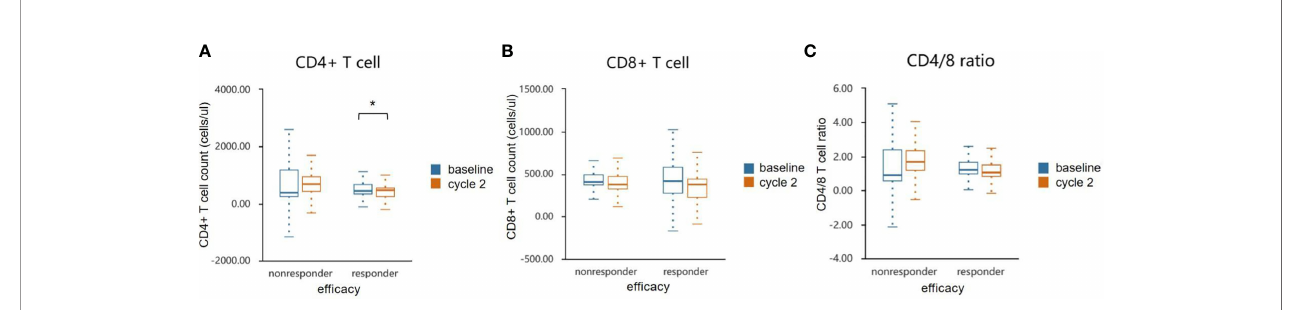
FIGURE 4 | Effects of combination therapy on circulating lymphocyte population cells in the responder and non-responder groups. The absolute numbers of CD 4+ (A) , CD 8+ T cells (B) and CD4/8 ratio (C) were calculated at baseline and after two cycles treatment. Wilcoxon paired t-test was performed to detect the statistical signi fi cance (* P < 0.05).